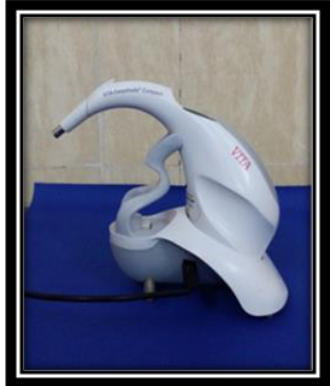
Fig. 3: Spectrophotometer VITA